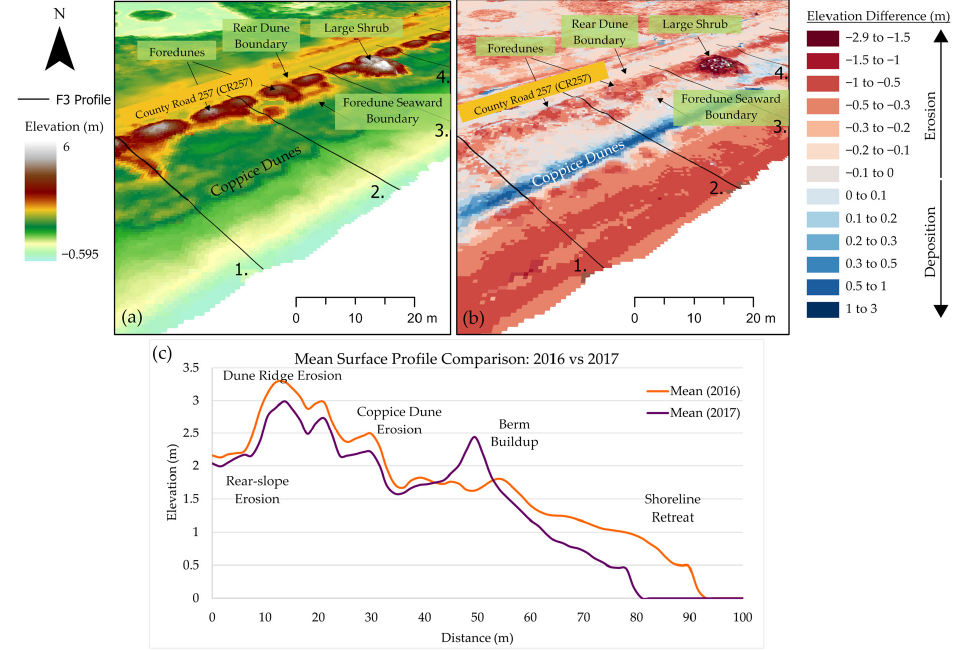
Figure 11. 3D models of Follett’s Site 3. ( a ) A 3D model of 2016 USACE’s edited topobathy lidar- derived DEM with 4 shore perpendicular transects used to compare pre- and post- storm beach profiles within Follett’s Site 3; ( b ) DEM Difference Map was created using USACE’s 2016 and BEG’s 2017 surface elevation data draped over the 2016 elevation model to show changes to the site after Harvey; ( c ) The 2016 and 2017 mean profiles for transect 2 overlayed for comparison .